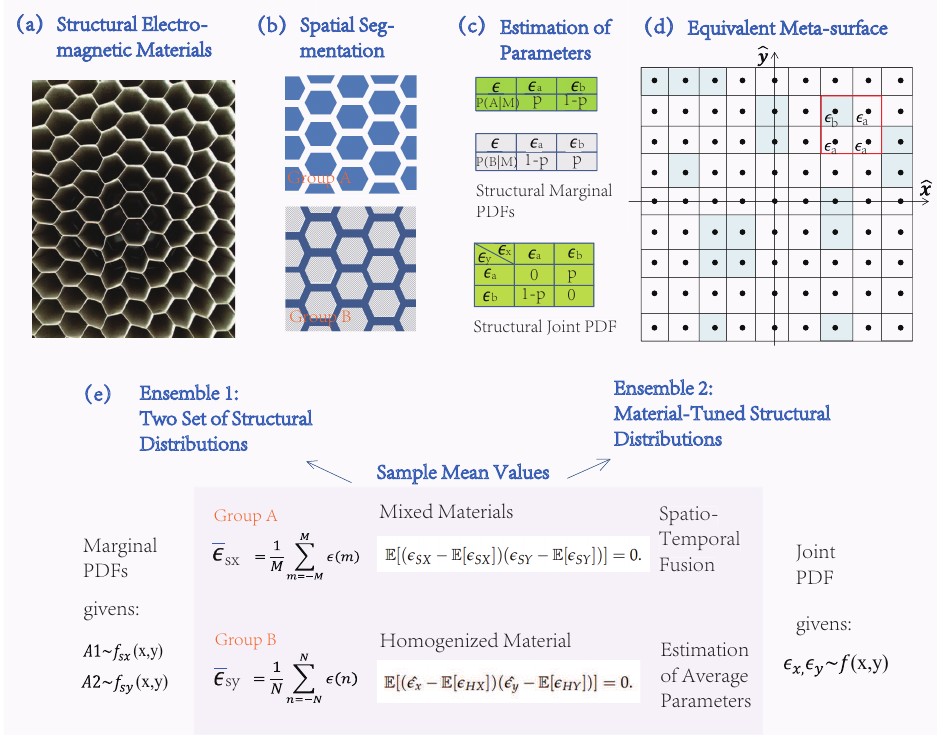
Figure 1. The method of SEA to estimate the effective permittivity of a honeycomb-structured meta-surface: ( a ) the cross-section of aramid paper sample with slightly distortion; ( b ) modeling of materials in two subspaces; ( c ) the structural PDFs; ( d ) the digital-coding information meta-surface; ( e ) parameter